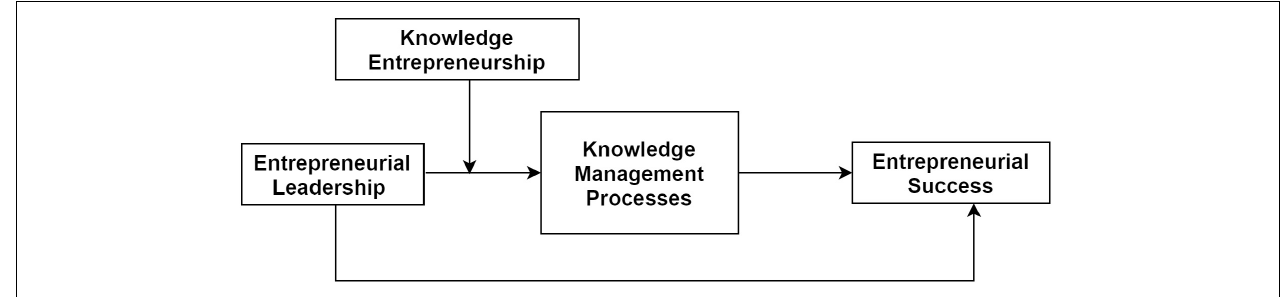
FIGURE 1 | Conceptual